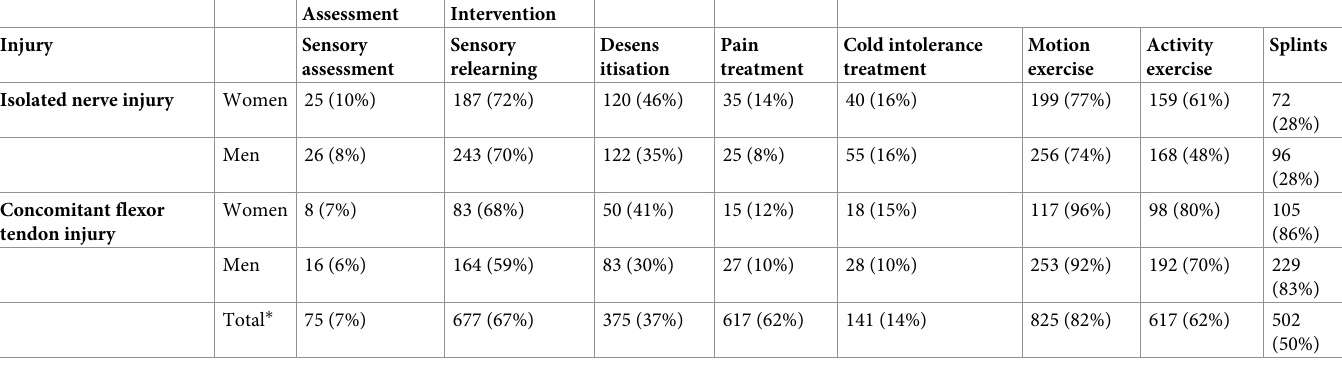
Table 5. Number of patients subject to rehabilitation after surgical treatment for a digital nerve injury in Stockholm, Sweden, 2012–2018.